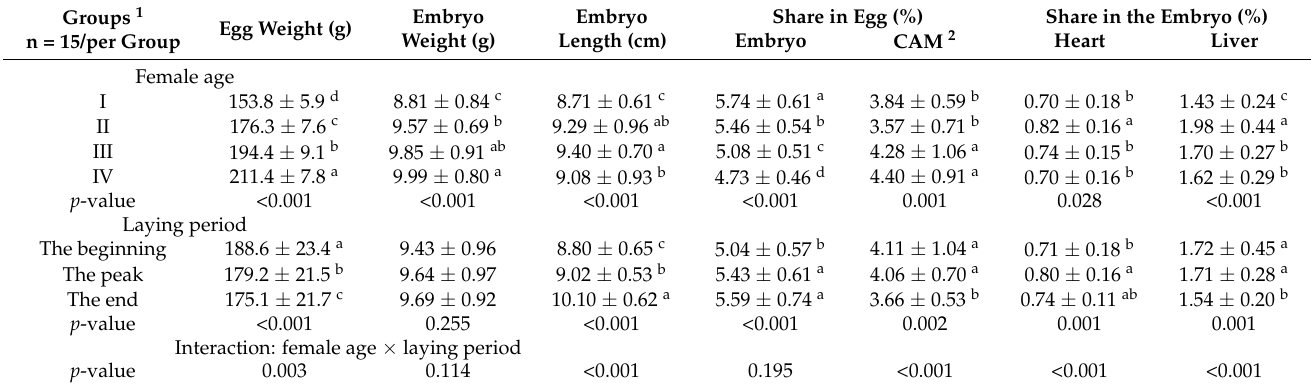
Table 1. Embryonic development of goose embryos on the 16th day of incubation.